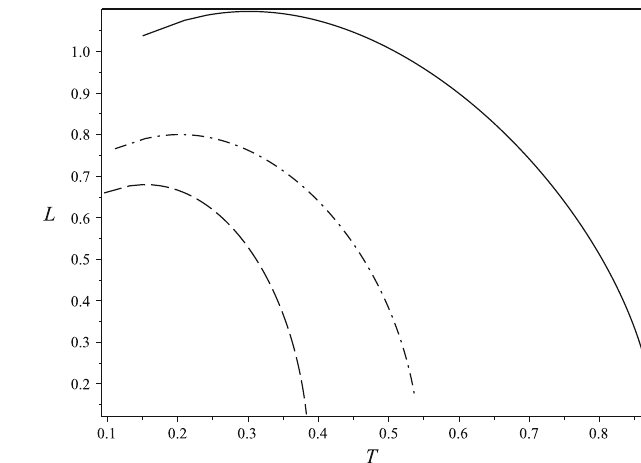
Fig. 9 The left graph represents the latent heat L as a function of tem- perature T for different values of α when n is fixed, namely n = 3 (in particular b = 1, q = 0 . 1 for both graphs) and α = 0 . 1 (solid curve), α = 0 . 3 (dashed curve) and α = 0 . 5 (dash-dotted curve). The right